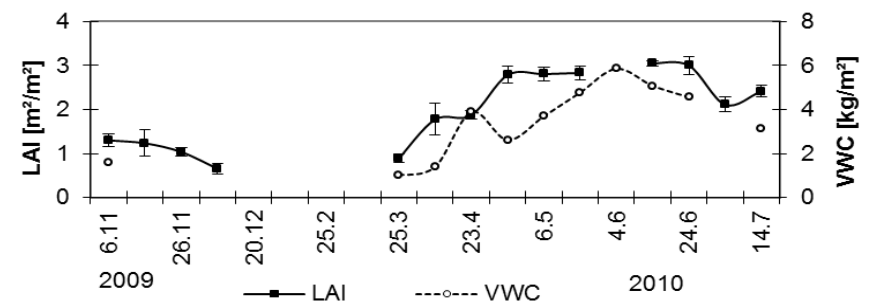
Figure 4. Development of vegetation water content and leaf area index for the duration of the experiment.